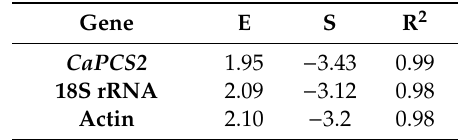
Table 2. Quantitative real-time polymerase chain reaction (RT–PCR) standard-curve parameters for target gene ( CaPCS2 ) and the expression control (housekeeping)